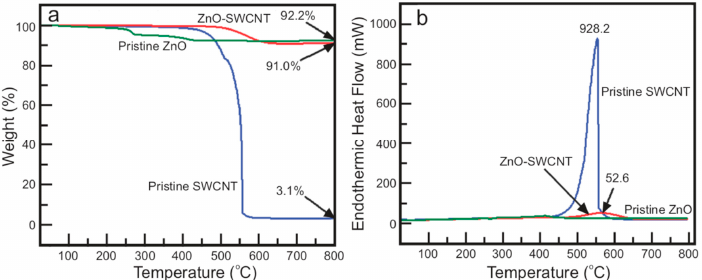
Figure 7. Thermal analysis of the ZnO–SWCNT nanocomposite, the pristine ZnO, and the pristine SWCNTs: ( a ) TGA curve and ( b ) DSC curve.